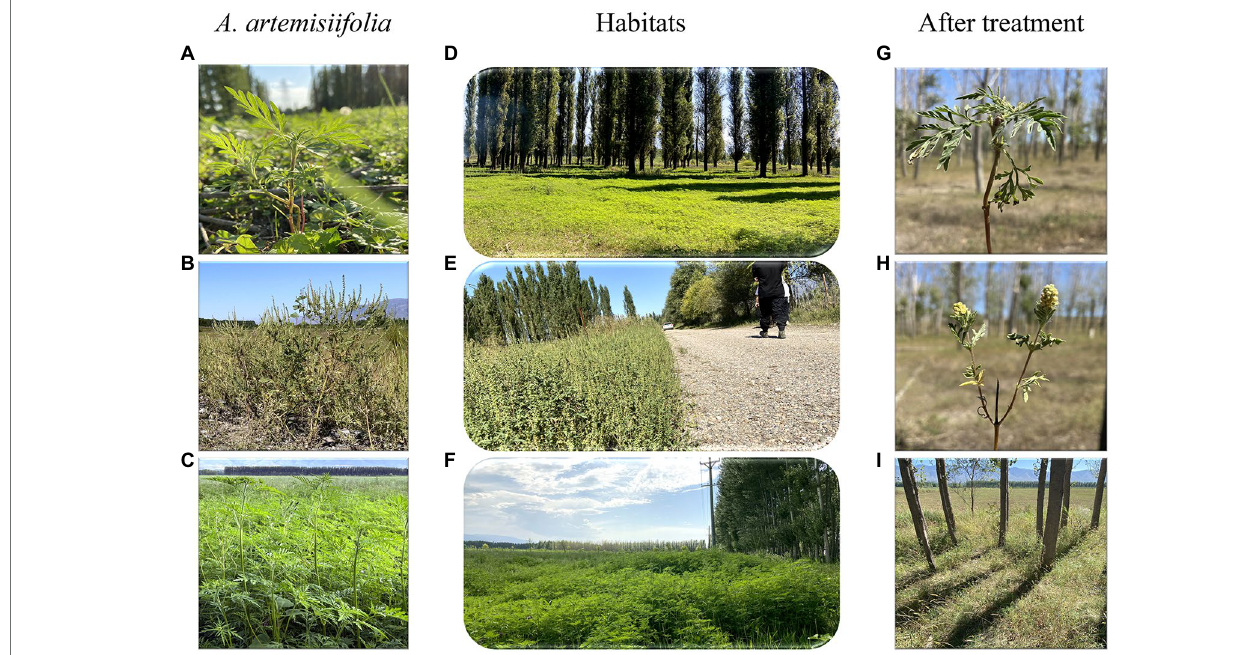
FIGURE 1 | Study site and herbicide effects on habitat and plants. Panels (A–C) were Ambrosia artemisiifolia in woodland (D) , roadside (E) , and farmland (F) habitats, respectively. Panel (G) indicated that A. artemisiifolia couldnot flower after herbicide application. Panel (H) indicated that although A. artemisiifolia could flower after herbicide application, it produced only few seeds. Panel (I) showed that A. artemisiifolia disappeared from the habitat after 2 years of herbicide application.